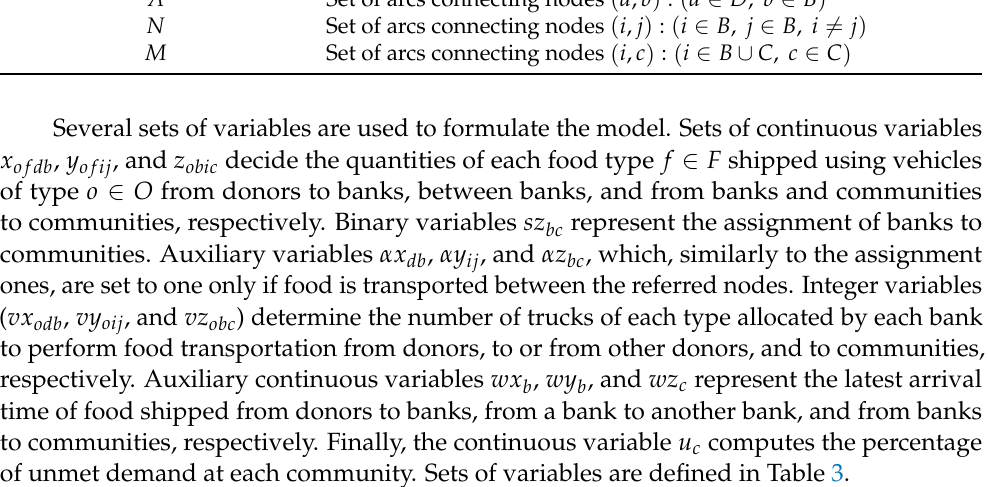
Table 3. Sets of variables used in the model